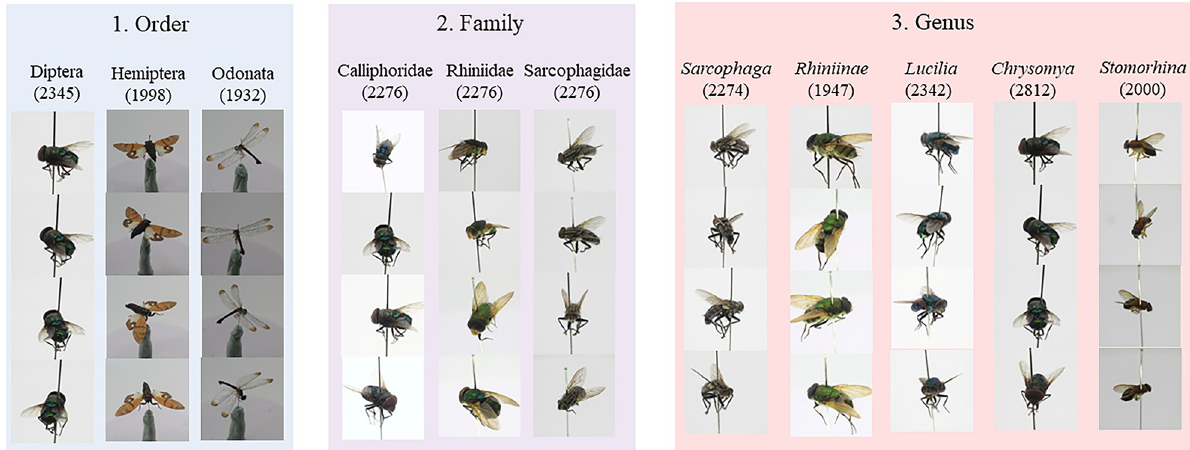
Fig 2. Results of dataset construction: Three datasets regarding the taxonomic levels order (three classes, Diptera, Hemiptera, Odonata), family (three classes, Calliphoridae, Rhiniidae, and Sarcophagidae), and genus (five classes, Chrysomya, Lucilia, Rhiniinae, Sarcophaga, and